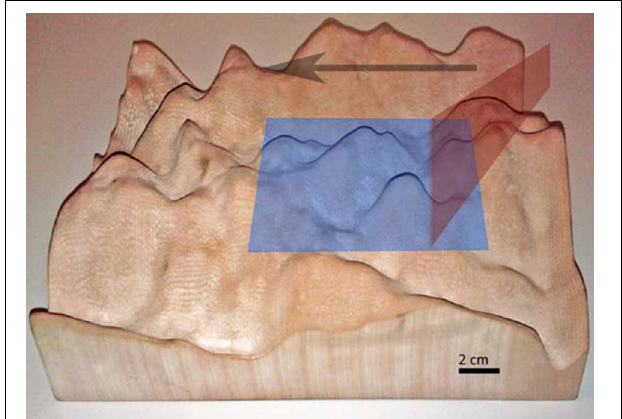
FIGURE 7 | Number of events at a pixel per laser pulse of a 4.75mW point laser. Although the event count drop with higher frequencies, the average does not drop below 1 event per cycle even at